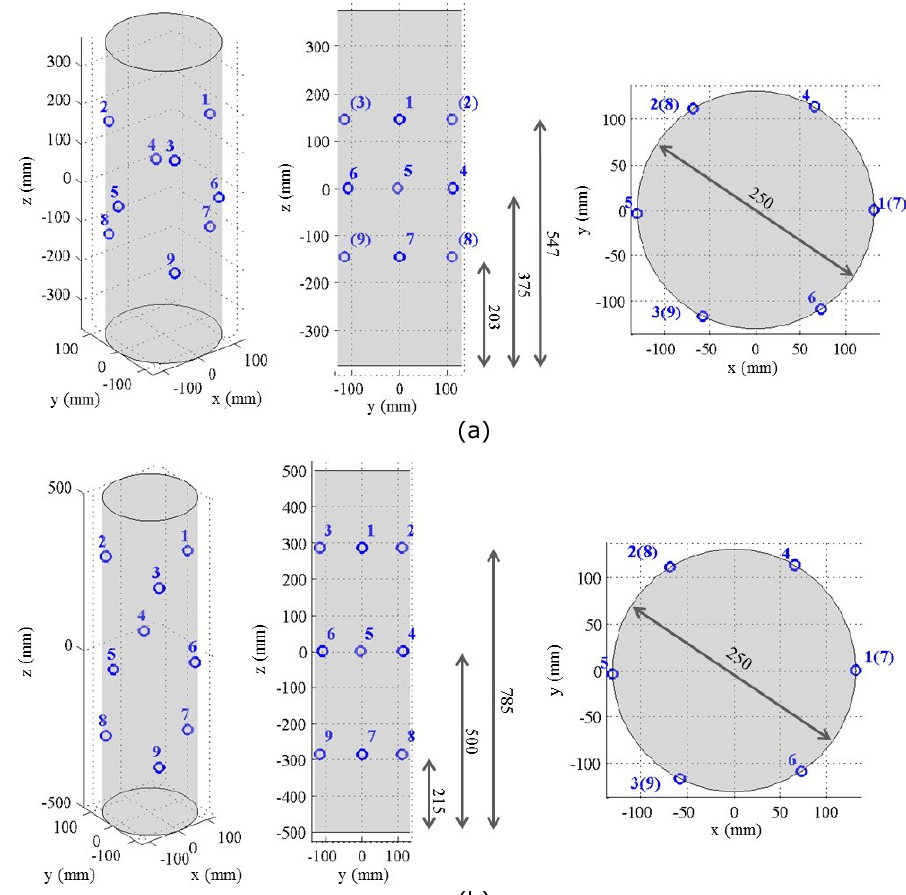
Figure 3. Position of Acoustic Emission (AE) sensors ( a ) specimens F6S120S and F12S100S, and ( b ) specimens F6S120L and